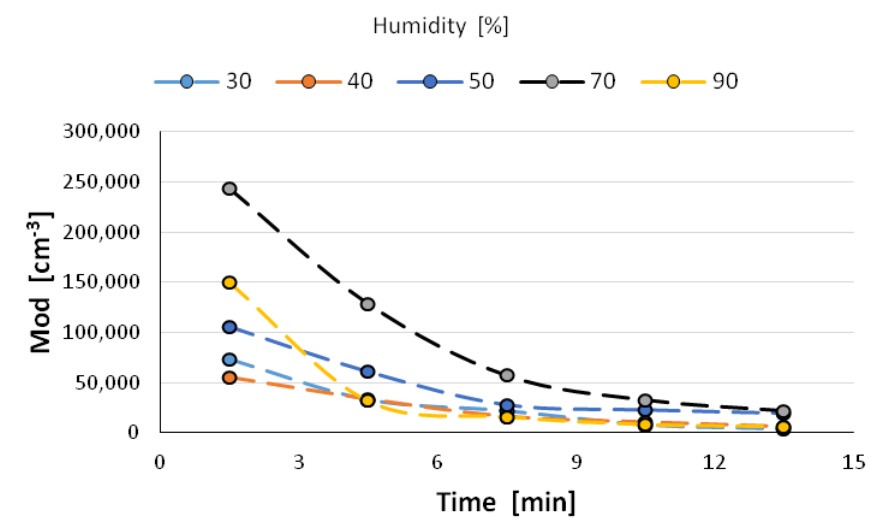
Figure 11. Change in nanoparticle abundance of the most common fraction.